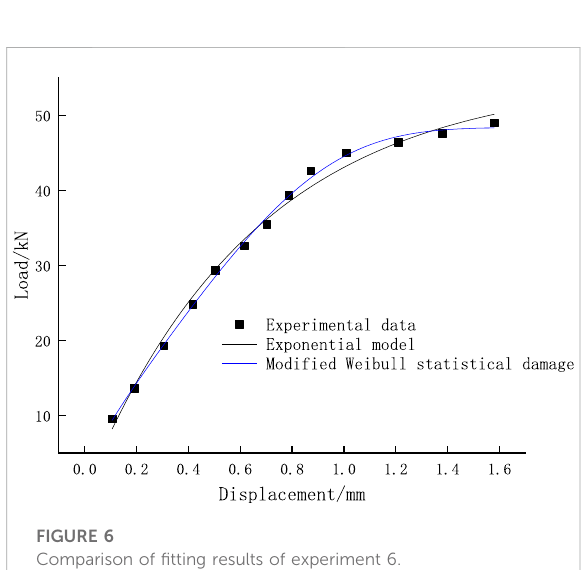
FIGURE 5 Comparison of fi tting results of experiment 5.